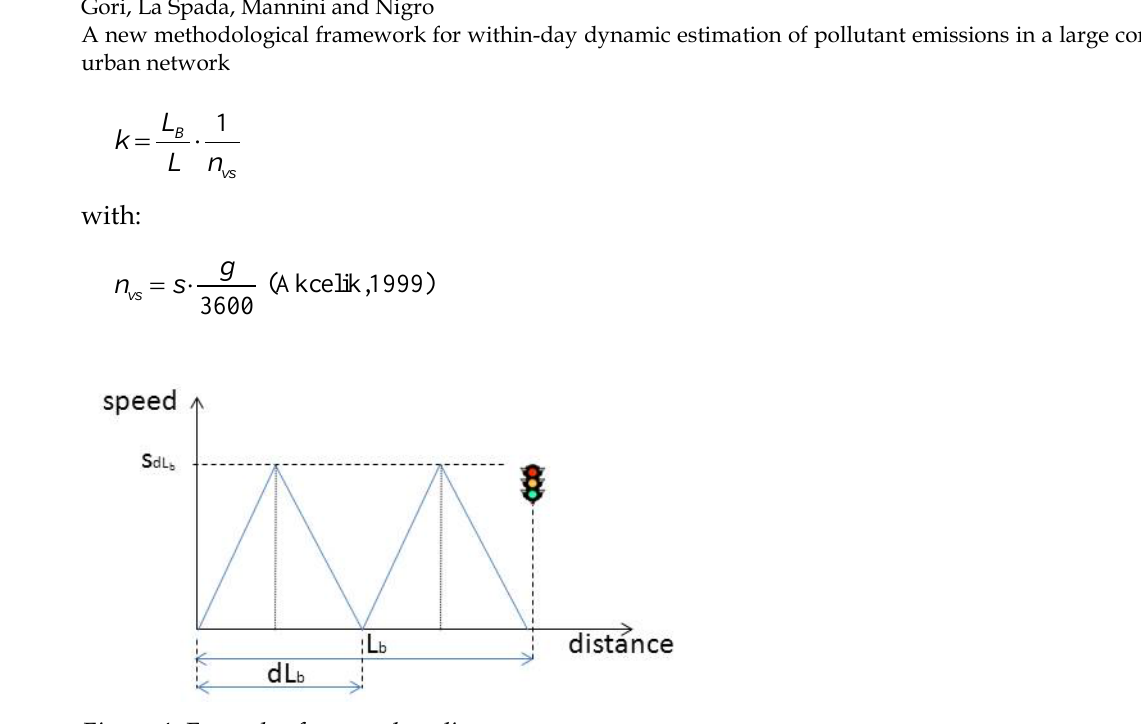
Figure 4. Example of stop and go